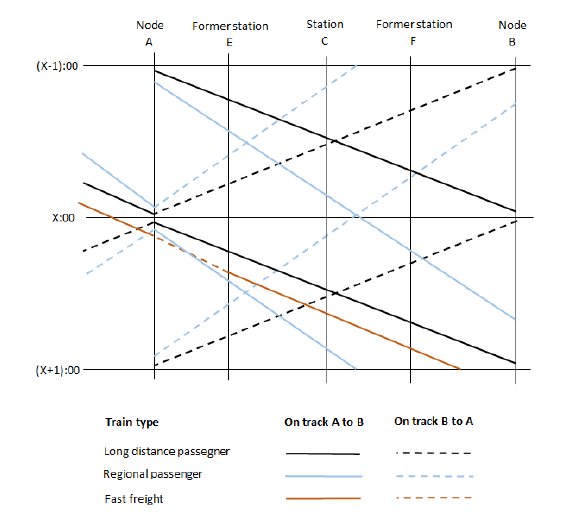
Figure 1. Possible situation of active overtaking on a double-track